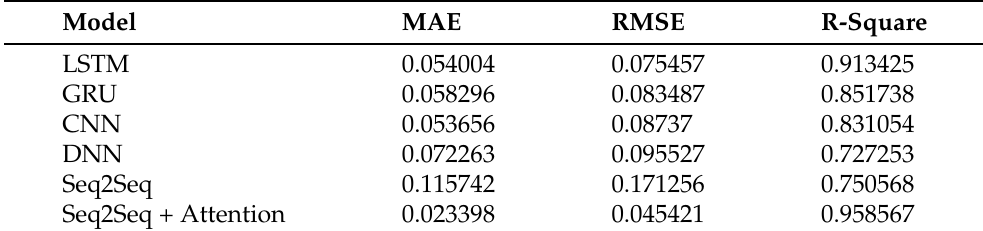
Table 1. Prediction evaluations.